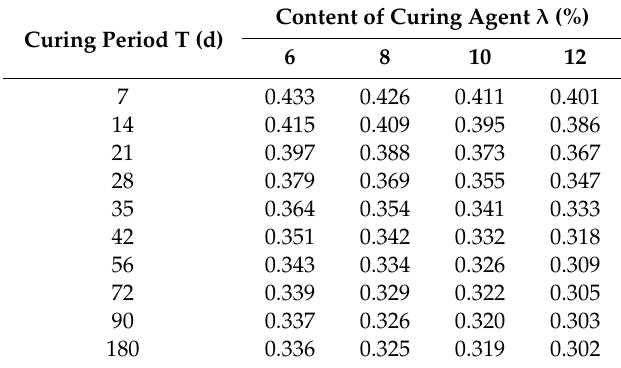
Table 6. The plane pore ratio of the solidified calcareous sand.